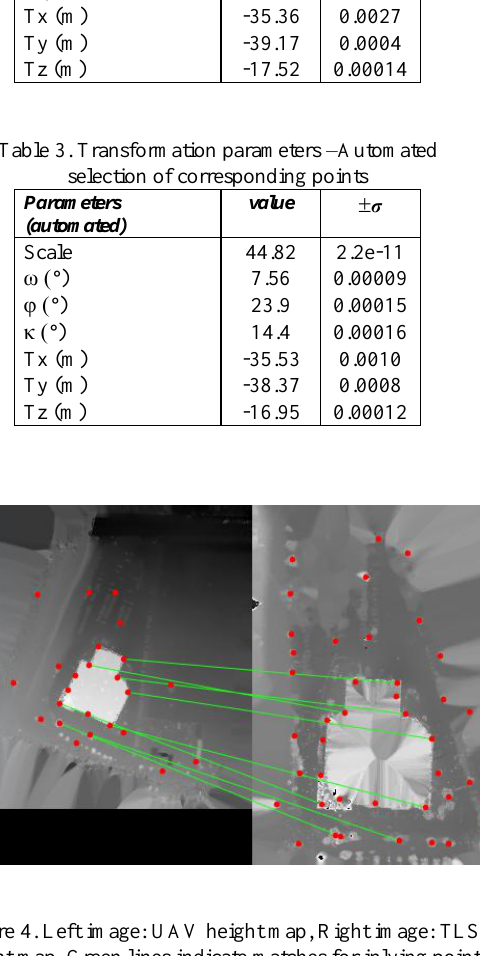
Figure 4. Left image: UAV height map, Right image: TLS height map. Green lines indicate matches for inlying point matches.